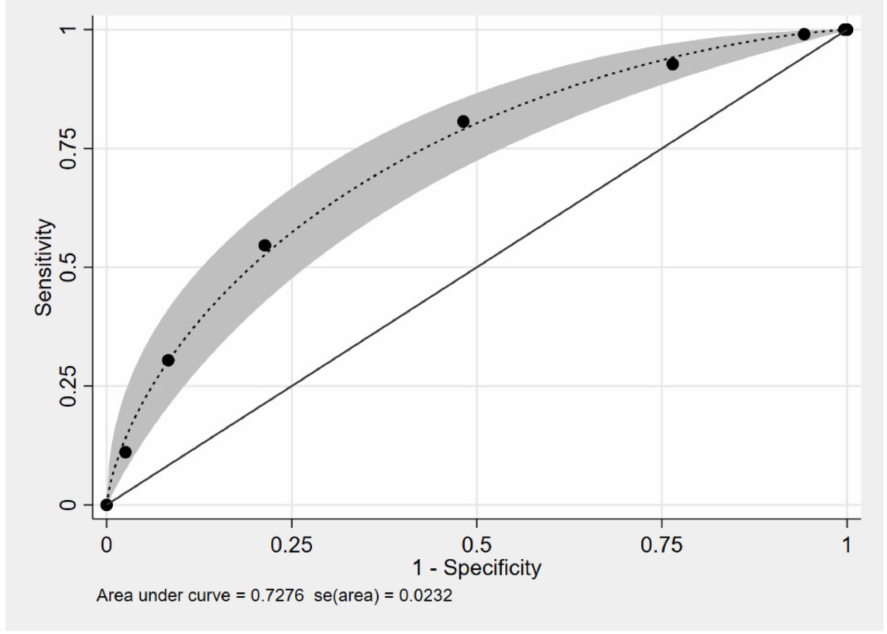
Figure 2. Performance of the clinical model score, area under the receiver operating characteristics (ROC) curve, and 95% confidence